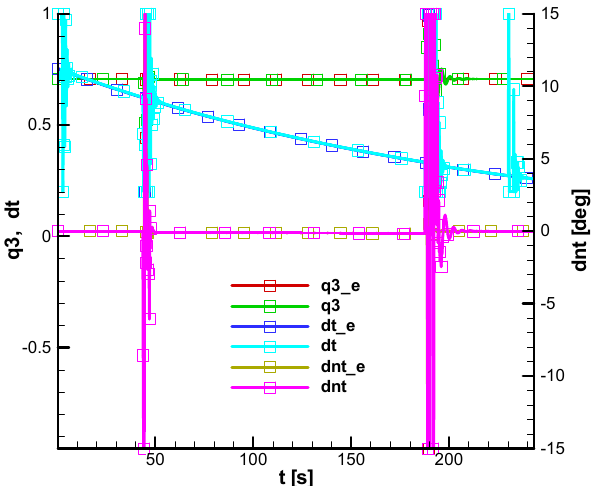
Figure 16. The equilibrium commands and q3 component for evolution in the second scenario.